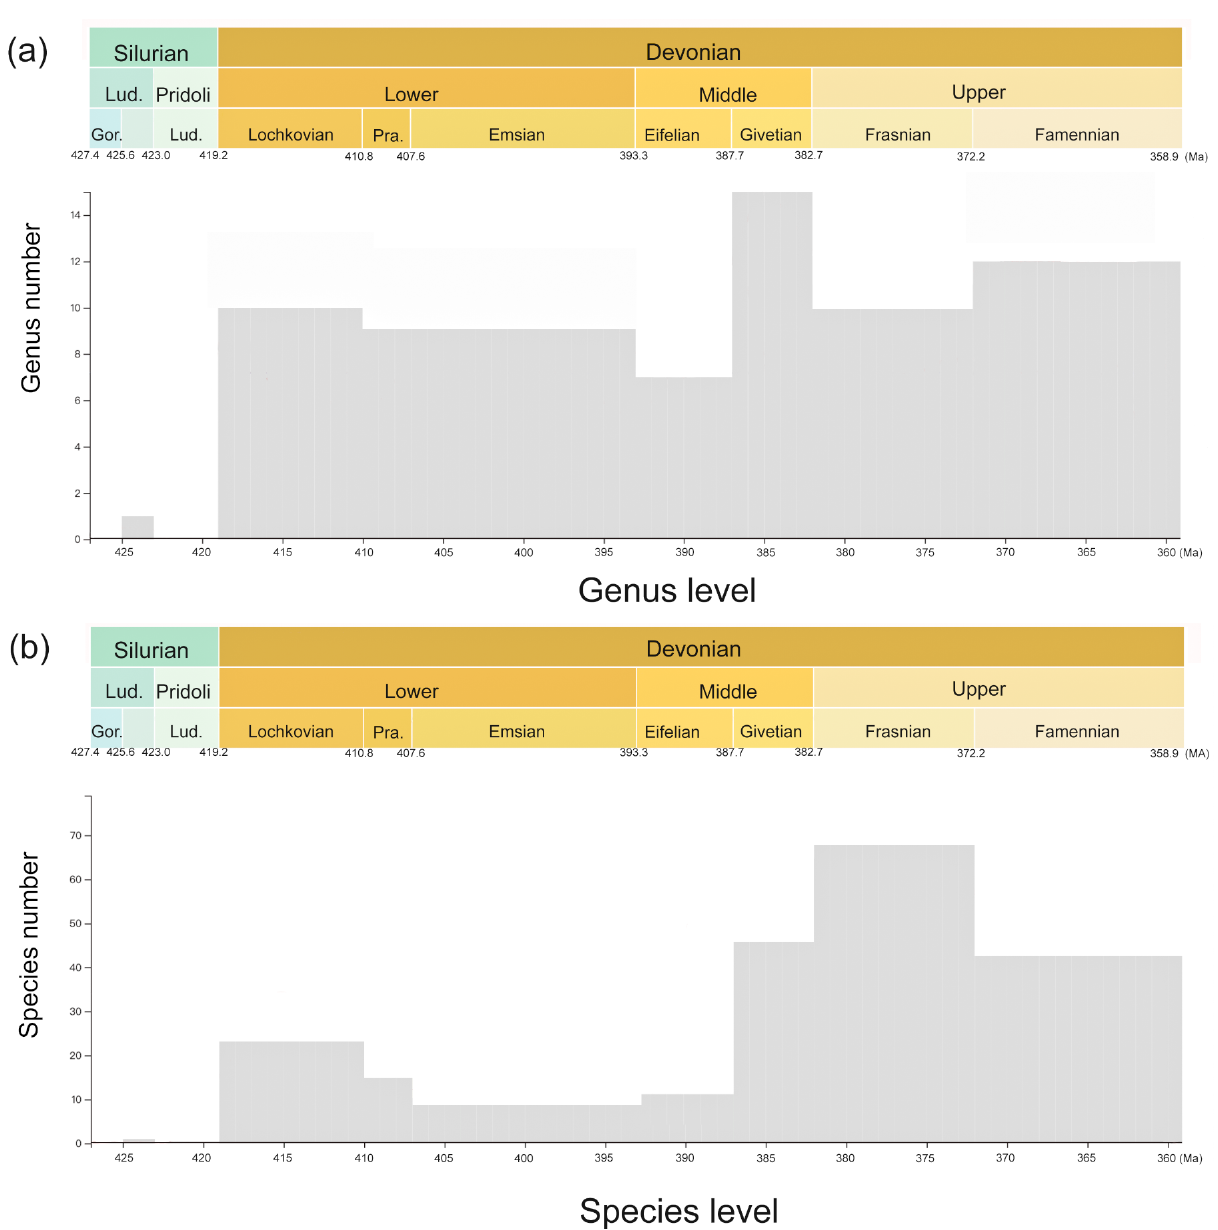
Figure 3. Histogram of specimen number. (a) The genus number at different time intervals and (b) the species number at different time